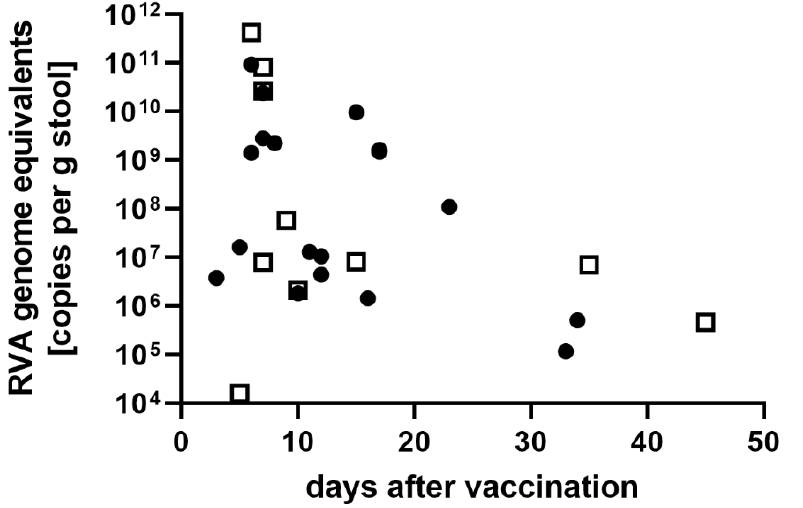
Figure 2. RVA genome equivalents (viral load) detected in samples from immune-competent vac- cinees (no known immune deficiencies). Closed circles: samples from RV1-vaccinated children, open squares: samples from RV5-vaccinated children.